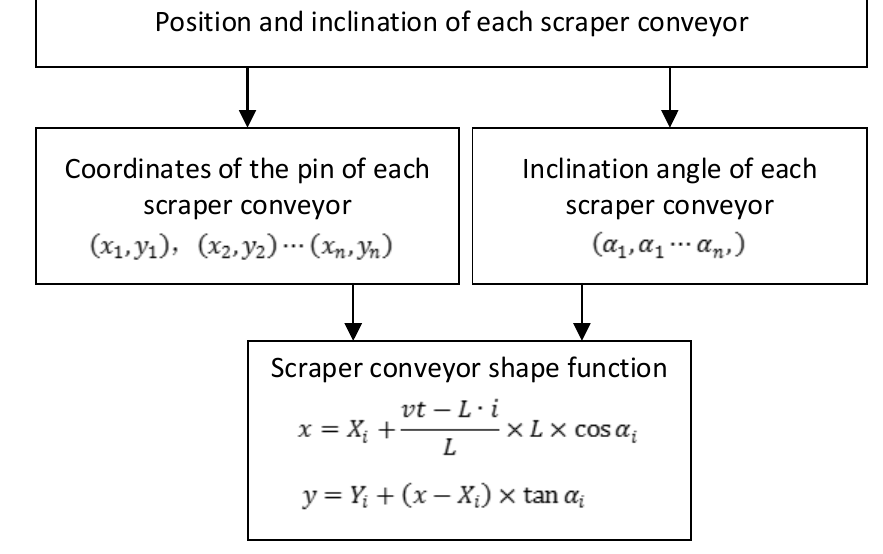
Figure 8. Shape function of the scraper conveyor.